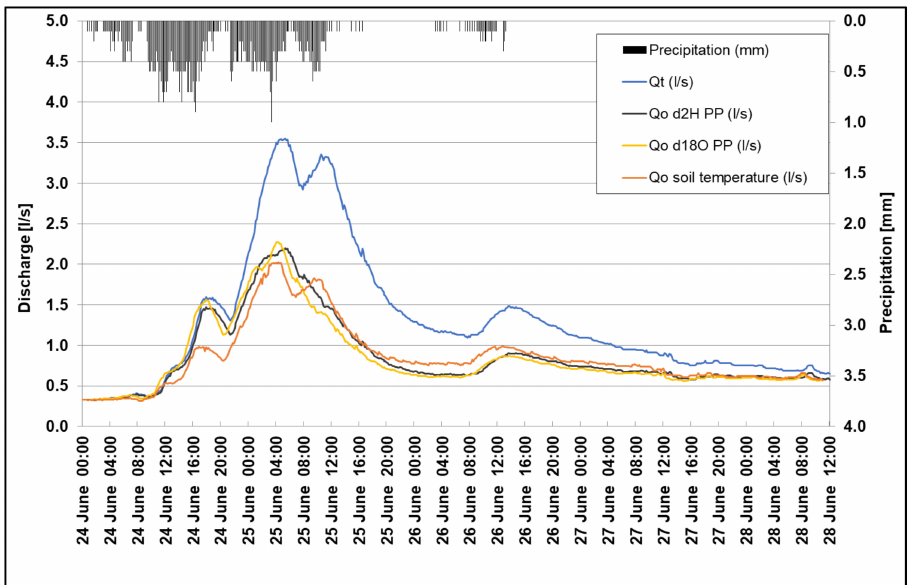
Figure 3. The course of runoff separation in SST-NSE based on isotopes of previous precipitation and soil temperature in RRE 10-KL (24 June 2013). Qt, total discharge; Qo d2H, discharge of the old water by separations using δ 2 H values of previous precipitation; Qo d18O, discharge of the old water by separations using δ 18 O values of previous precipitation; Qo soil temperature, discharge of the old water by separations using previous precipitation temperature and soil temperature.